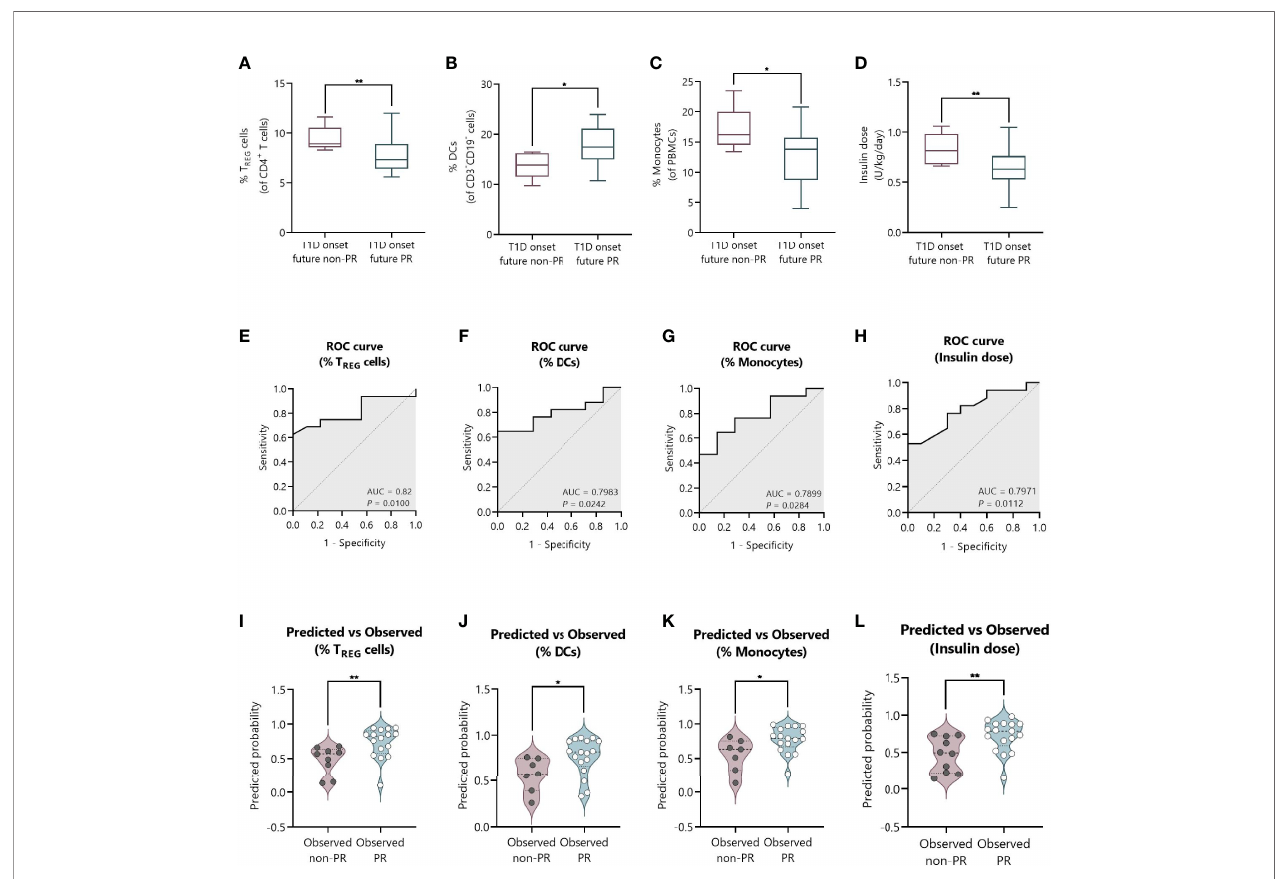
FIGURE 9 | The percentage of T REG , DCs, and monocytes, and the total daily insulin dose at T1D onset can discriminate between future remitters and non- remitters. (A – D) Box-and-whisker plots showing the percentage levels of (A) T REG , (B) DCs, and (C) monocytes, and (D) insulin dose at T1D onset separated by future remitters (blue boxes) and non-remitters (pink boxes). Boxes indicate the fi rst and third quartiles and whiskers range from minimum to maximum values. The horizontal bar in the box indicates the median. (E – H) ROC curves plotting sensitivity and 1-speci fi city for detecting children with PR using percentages of (E) T REG , (F) DCs, and (G) monocytes, and (H) insulin dose. The AUC is indicated, being a measure of how well a quantitative test can distinguish between patients with and without PR. (I – L) Violin plots showing the frequency distribution of predicted probabilities for both the observed PR and non-PR groups regarding the percentage of (I) T REG , (J) DCs, and (K) monocytes, and (L) insulin dose. Each dot represents an individual patient. Violin plots show the median (thick dashed line) and fi rst and third quartiles (thin dashed lines). * P ≤ 0.05, ** P < 0.01 after 2-tailed Mann – Whitney test. P ≤ 0.05 is considered signi fi cant. N = 24 –